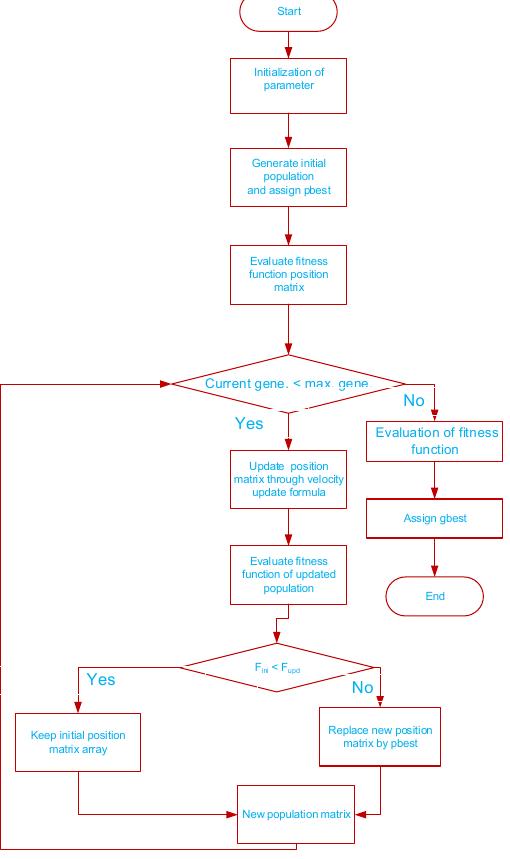
Figure 3. WDO algorithm implementation